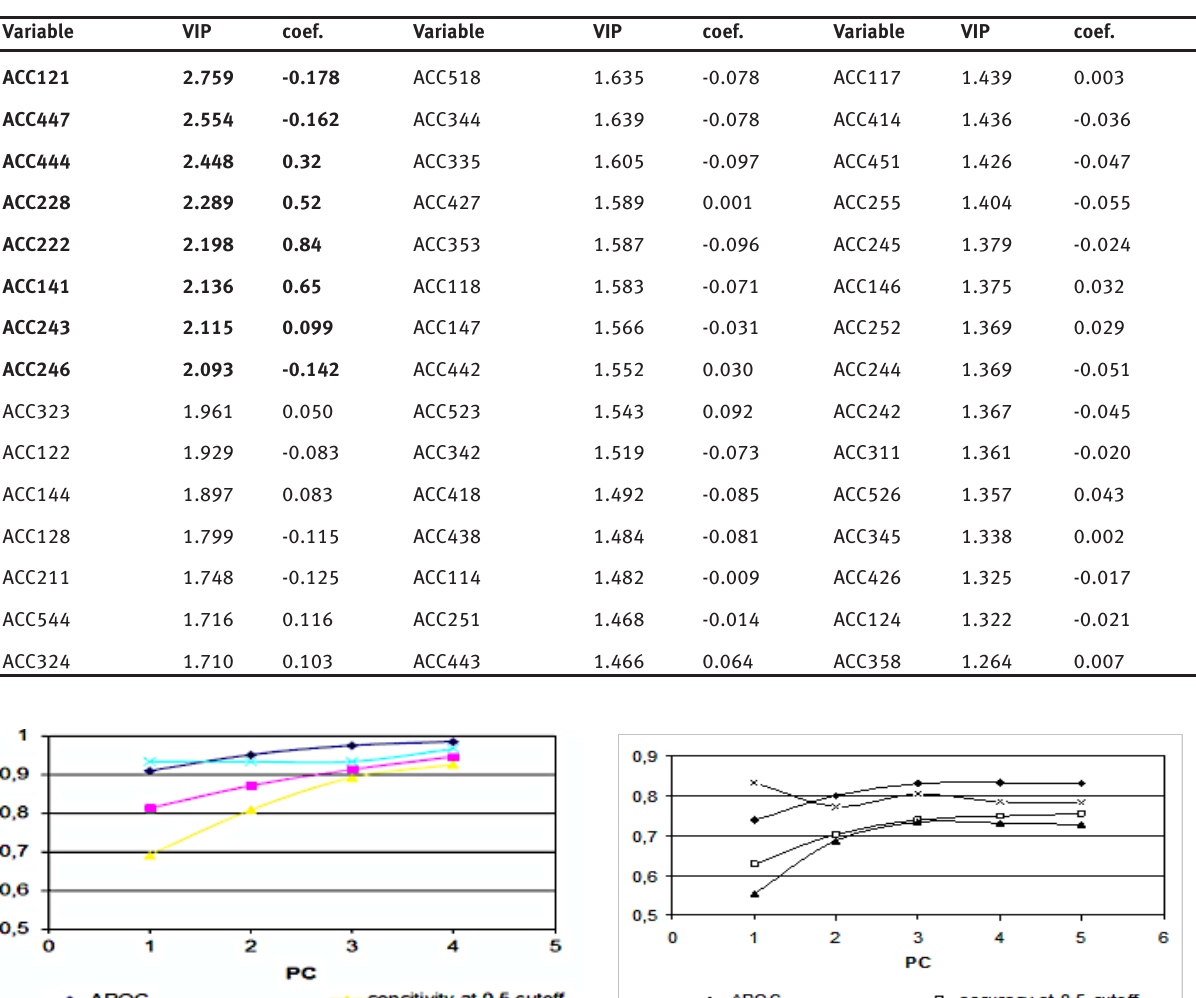
Table 2: VIP values and coefficients of the preliminary model for allergenicity prediction. The constant of the model is 0.998. Variables with VIP > 2.0 and coefficients > |0.100| are given in bold.